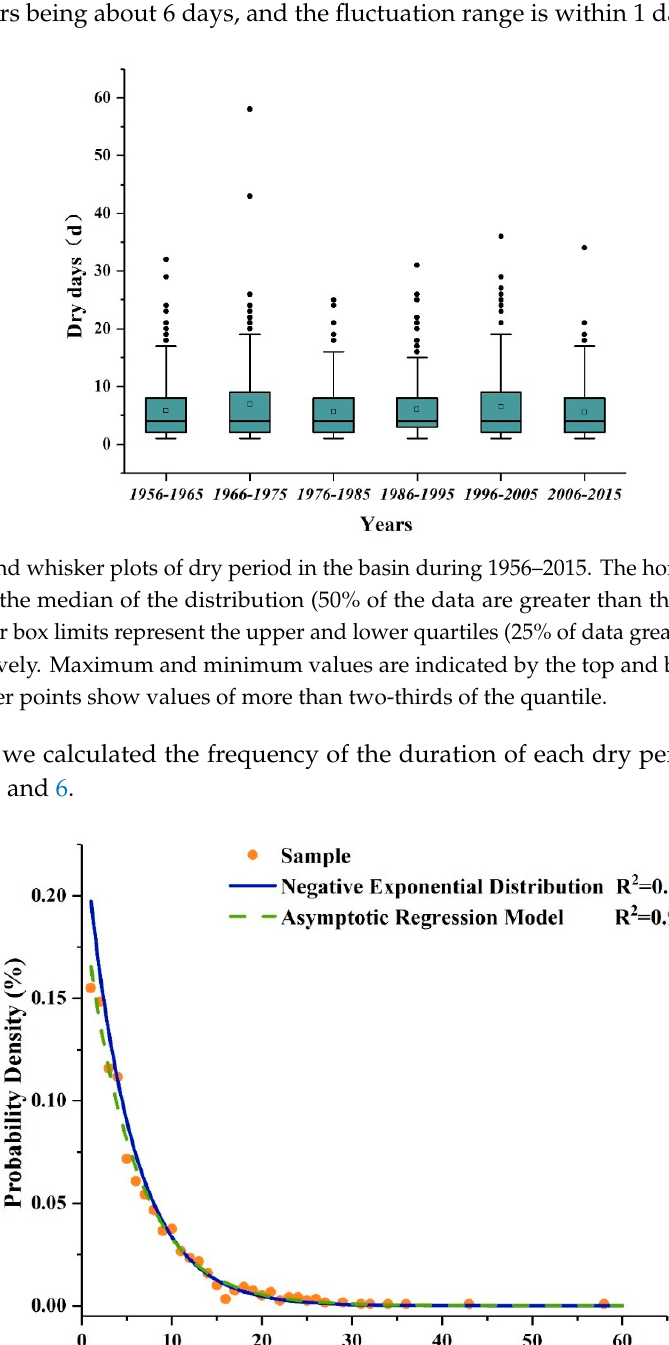
Figure 6. Probability function of dry days. According to the fitting results of the two methods, the distribution function of the dry period duration was obtained and the statistical parameters of duration in dry period were extracted, as shown in Table 2. Table 2. Statistical parameters from dry periods. Dry Days (d)